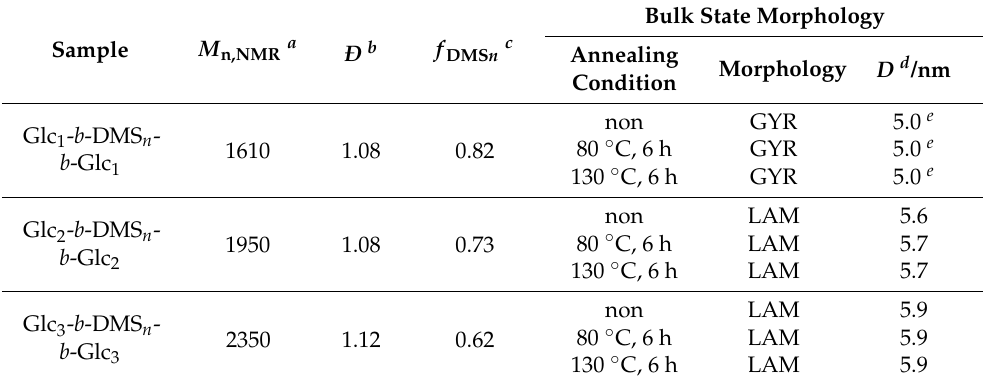
Table 1. Molecular characteristics of Glc m - b -DMS n - b -Glc m ( m =